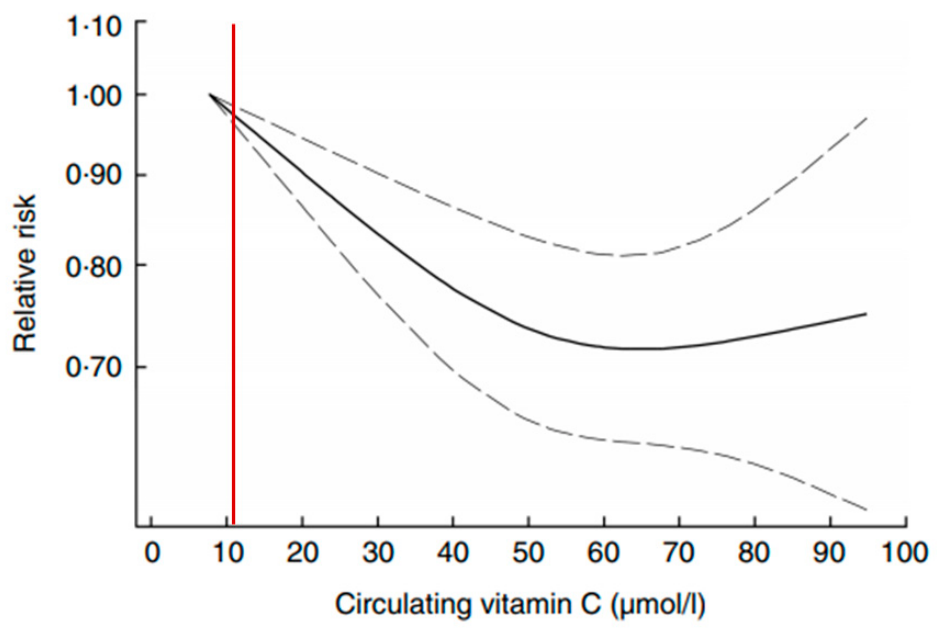
Figure 2. Dose–response association between vitamin C concentration and risk of total CVD mortality with 95% CI from 6 studies with 45,040 participants and 2992 cases. From [56]. Vertical red line indicates vitamin C deficiency, i.e., blood ascorbic acid < 11.4 µmol/L, used in setting DRI [28].